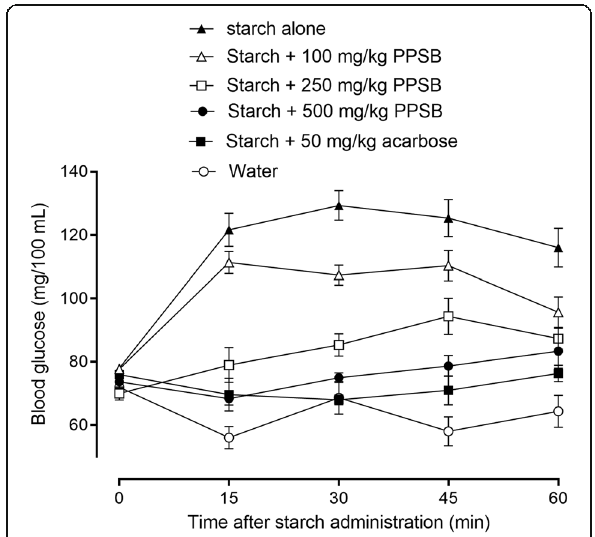
Fig. 2 Influence of the P. pluviosa aqueous alcohol extract (PPSB) administration on the glycemic levels of fasting rats during 60 min following starch administration. Each datum point represents the mean ± mean standard errors of four experiments. Experimental details are given in the Materials and methods section